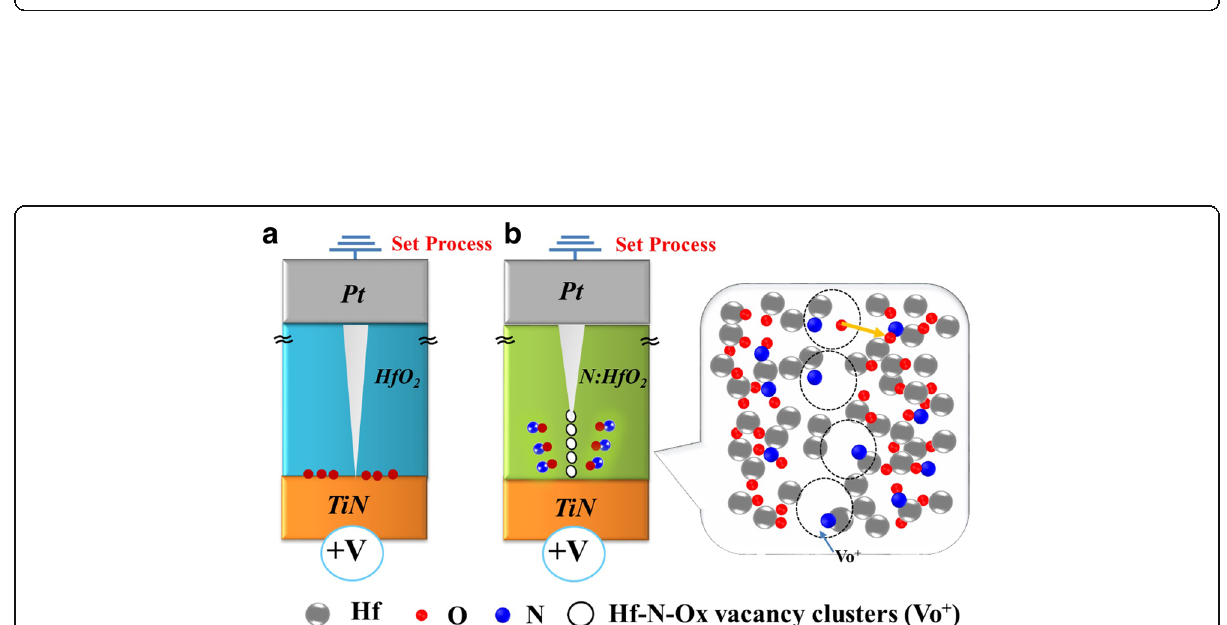
Fig. 5 A schematic of the migration of oxygen ions through the set process in HfO 2 -based RRAM for a initial and b after nitridation treatment, which forms Hf – N – Ox vacancy clusters (V o+